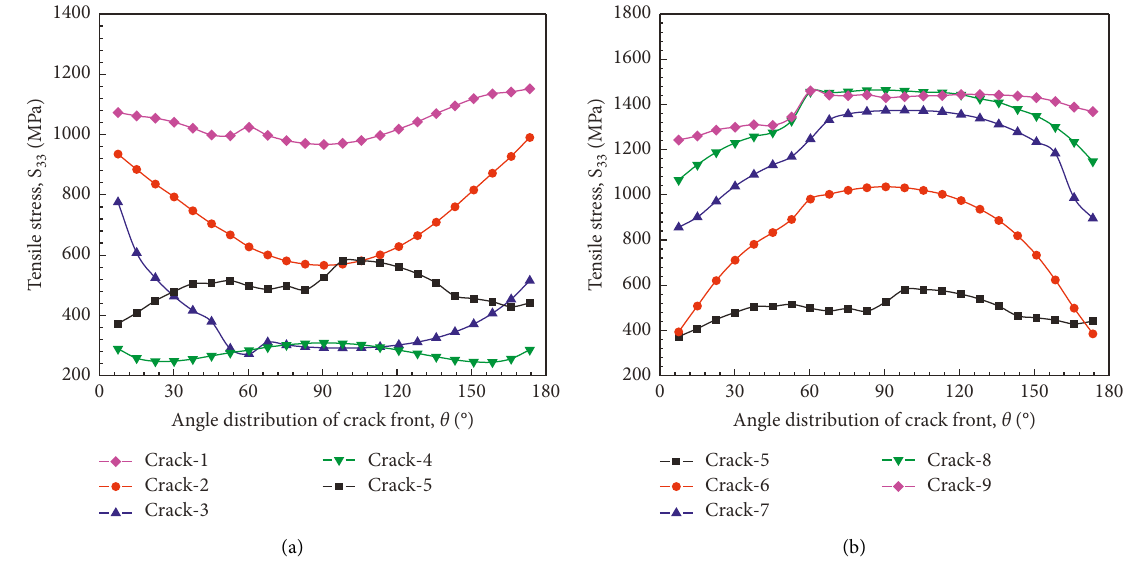
Figure 11: Distribution of tensile stress along crack front with crack angle. (a) Cracks-1 ∼ 5. (b) Cracks-5 ∼ 9.